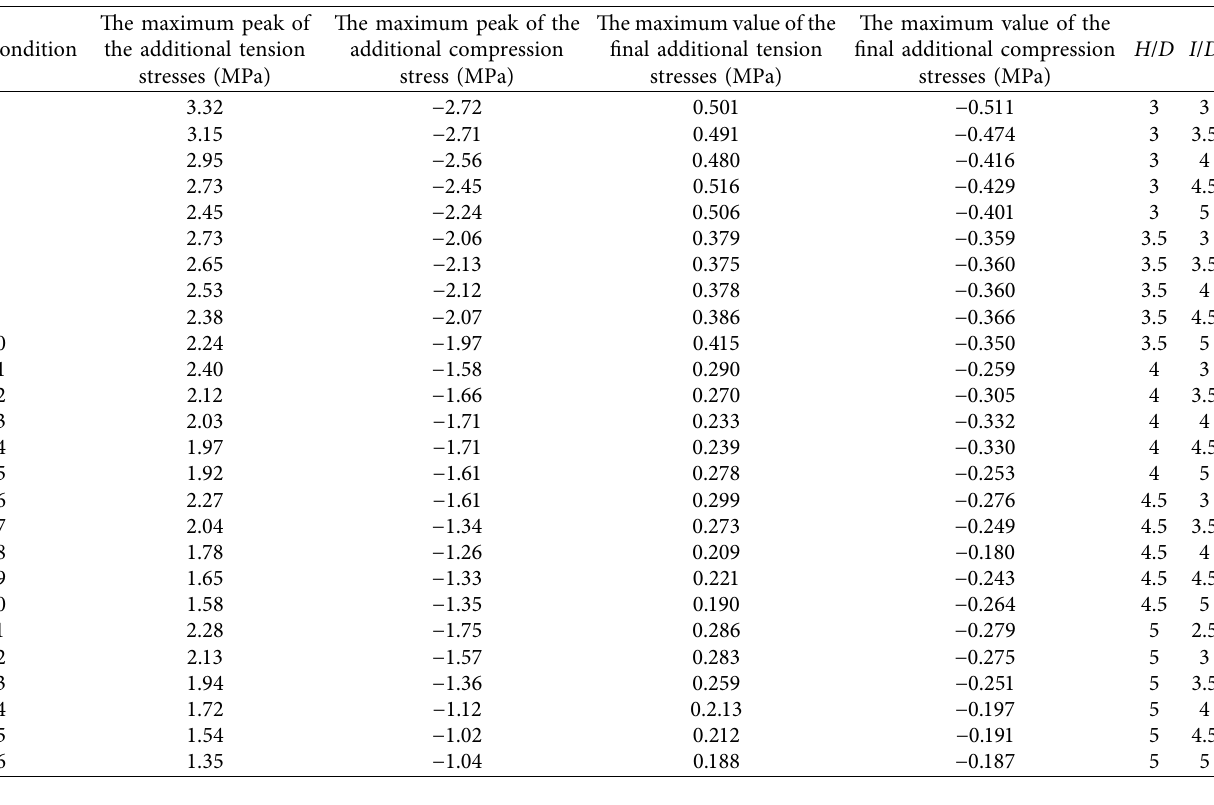
Table 6: Statistics of circular additional pressure of each